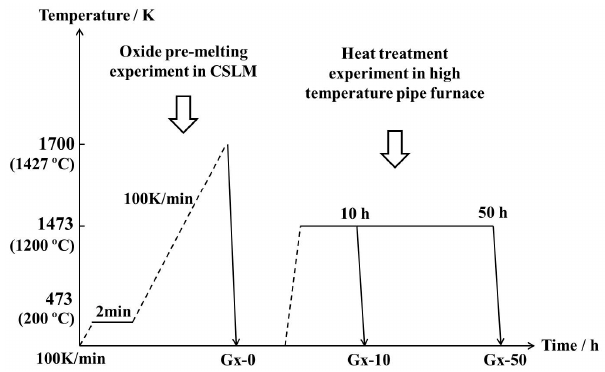
Figure 3. Temperature curve of the heat treatment for the diffusion couple specimens.